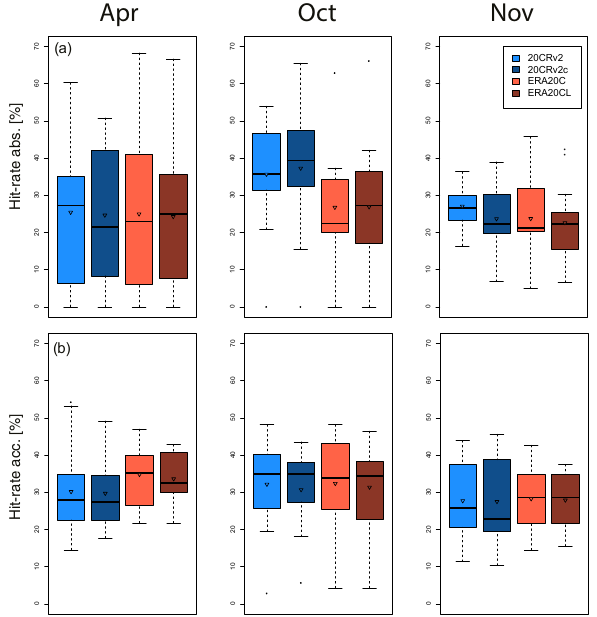
Figure 7. Boxplots graphs for the extreme events hit-rate analysis of the 13 snow depth station locations, where the triangle denotes the mean, the bold black line denotes the median, the box denotes the 25–75% percentile range (or interquartile range), the whiskers show the upper and lower end or at most the 1.5x interquartile range and the dots denote outliers. (a) shows boxplots for absolute snow extreme events for the longest possible time period, and (b) is the same as (a) but for snow accumulation. Hit rates are computed for the longest period possible. ERA-20C is labeled as ERA20C, and ERA-20C land is labeled as